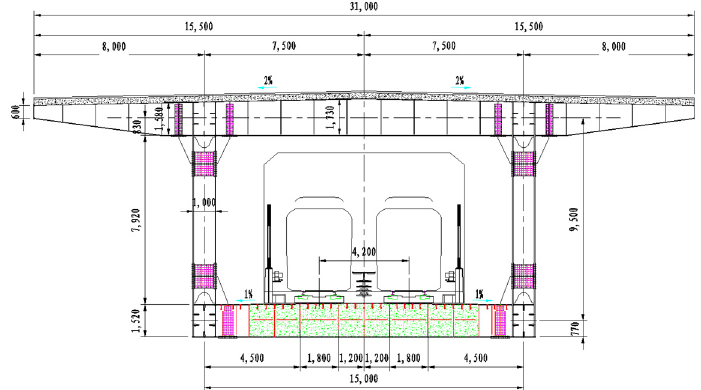
Figure 3. Cross section of ballast segment (Unit: mm).